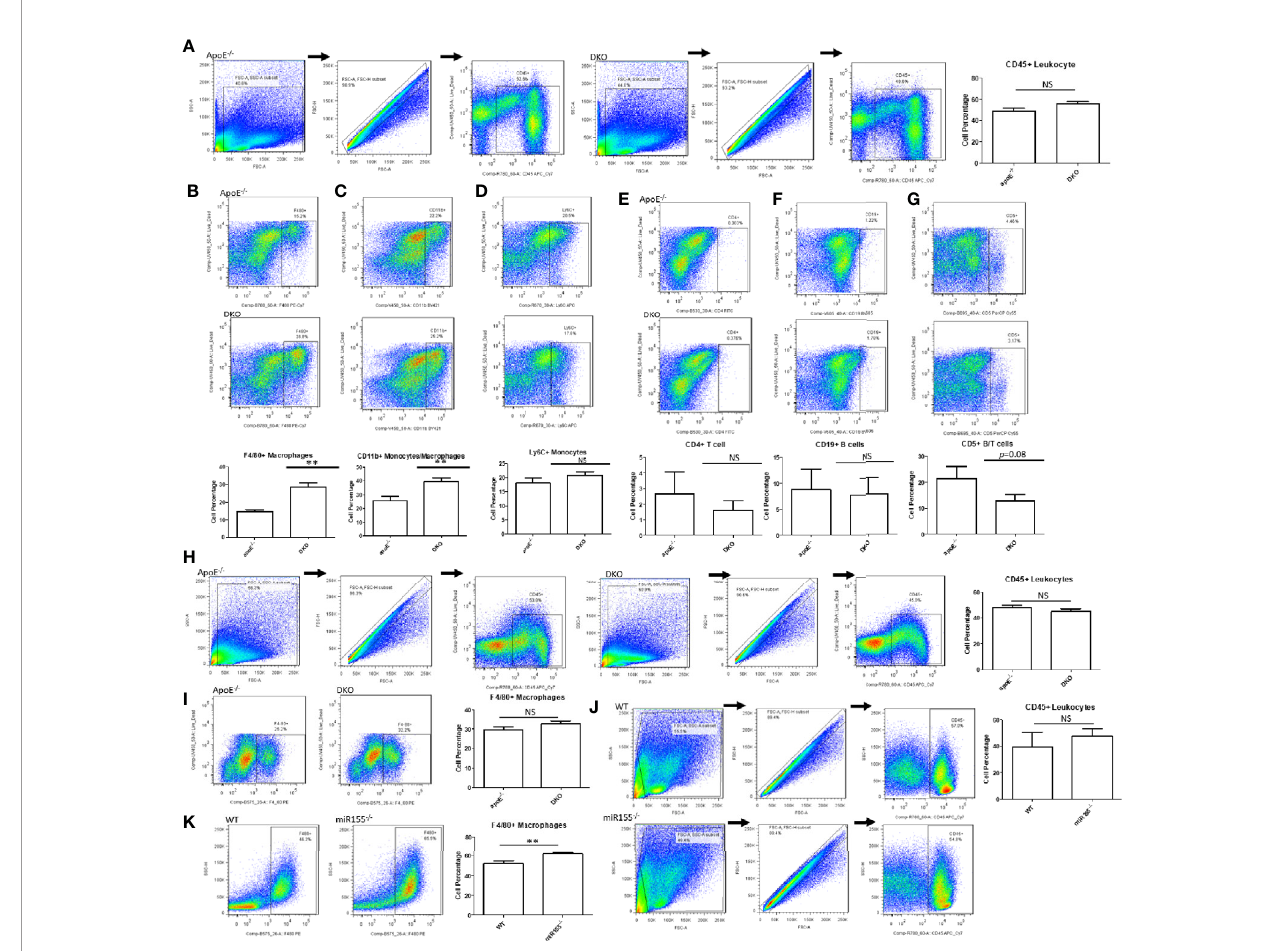
FIGURE 4 | Macrophages and monocytes are increased in miR155-de fi cient, high fat diet (HFD)-fed male mice in the presence or absence of ApoE background. Mice were fed on HFD from 8 weeks old to 20 weeks old. (A) Male mice: Total leukocytes were de fi ned as CD45+. Macrophages/monocytes were de fi ned as (B) CD45+F4/80+ or (C) CD45+CD11b+. (D) In fl ammatory monocytes were de fi ned as CD45+Ly6C+. (E) CD4+ T lymphocytes were de fi ned as CD45+CD4+. (F) B lymphocytes were de fi ned as CD45+CD19+. (G) B/T lymphocyte subsets were de fi ned as CD45+CD5+; ApoE -/- (n=7), DKO (n=11). (H) Female mice: Total leukocytes were de fi ned as CD45+. (I) Macrophages were de fi ned as CD45+F4/80+; ApoE -/- (n=5), DKO (n=4). (J) Male mice: Total leukocytes were de fi ned as CD45+. (K) Macrophages were de fi ned as CD45+F4/80+; WT (n=8), miR155 -/- (n=9). ** p <0.01. NS, not signi fi